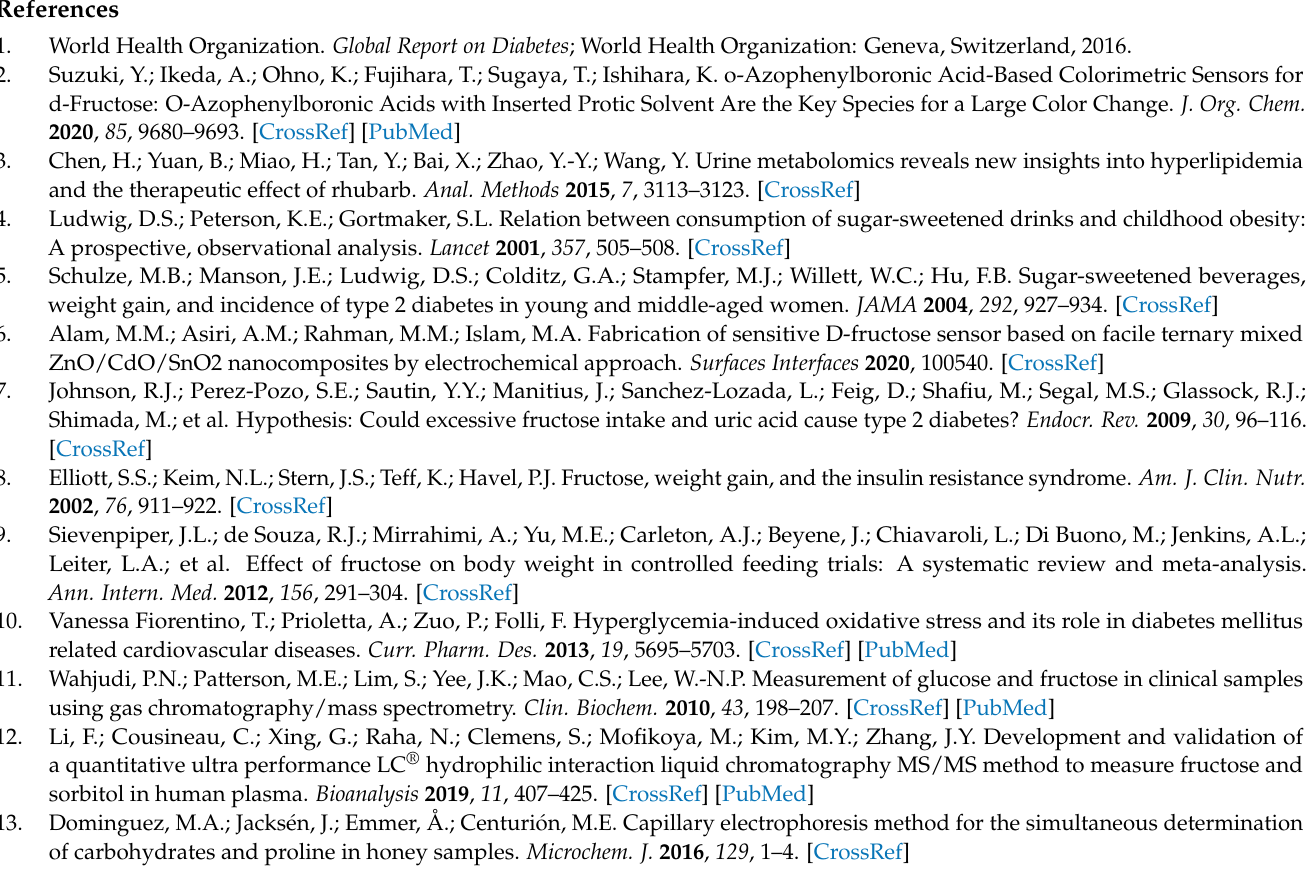
Figure S1: Bodes plot, complex impedance Z Ω measurement at 1 Hz frequency was used to study the interference effect of glucose using HPC-CoO electrode, Figure S2: Complex impedance Z Ω measurement at 1 Hz frequency was used to calculate the percentage of fructose in a local corn syrup sample, using HPC-CoO electrode, Figure S3: Long-term cycling of HPC-Co (1) and HPC-CoO (2) electrodes revealing minor decrease in the specific capacitance after 500